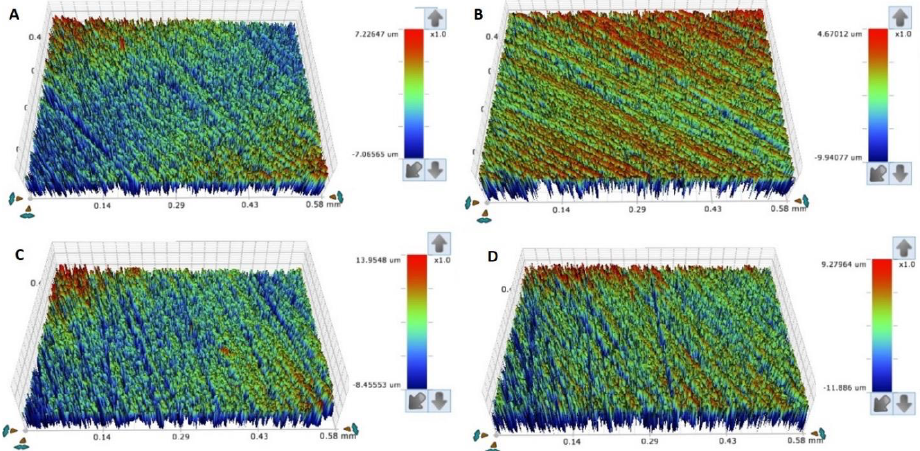
Figure 4. ( A – D ) Representative surface roughness images of scanned areas of HP and NextDent groups at 120 min. ( A ) HP, ( B ) 0-degree, ( C ) 45-degree, ( D ) 90-degree. A Shapiro – Wilk test was used for normal data distribution and showed insignificant results, therefore parametric tests were used for data analysis. One-way ANOVA was used when only one factor was adopted (such as time or orientation) to study its effect on surface roughness and hardness. Two-way ANOVA was used for the combined effect. With significant findings, the post hoc Tukey HSD test was used for pairwise comparison. All p -values less than 0.05 were considered statistically significant. 3. Results The mean and standard deviation (SD) of surface roughness of each group of orien- tation and post-curing time was summarized in Table 1 and Figure 5. The comparison of HP with AS and ND, separately for each factor (orientation and post-curing time) was analyzed and found most of the p -values were statistically significant. Only the signifi- cance was found due to variation in orientation degrees at 90 min and 120 min post-curing time ( p = 0.013 and =0.028, respectively) (Table 1). The pairwise comparison provided that, at both 90 min and 120 min, the pair HP vs. 45-degree had a significant difference in means ( p < 0.001). Similarly, in the comparison between HP with NextDent, when the orientation was at 90-degree, the variation due to post-curing time was found to be statistically sig- nificant ( p = 0.032) (Table 1). In the pairwise comparison, the difference in means in HP vs. 30 min was statistically significant ( p < 0.001). Furthermore, the combined effect of post- curing time and printing orientation on each material was analyzed using two-way ANOVA (Table 2). Results showed no significance regarding the combined effects per material (ASIGA; p = 0.768, and NextDent; p = 0.097). Table 1. Mean, SD, and significance of surface roughness (µm) test between groups. Materials